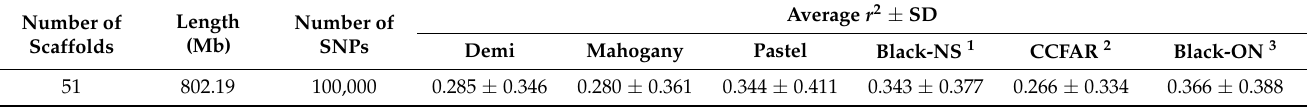
Table 5. The average r 2 ± SD between adjacent SNPs in five color-types of American mink.